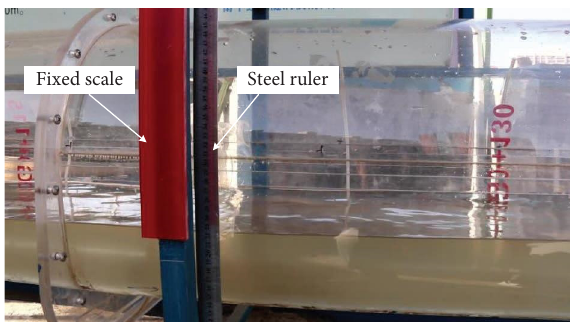
Figure 3: Te position relationship between the No. 12 fxed scale and the steel ruler.